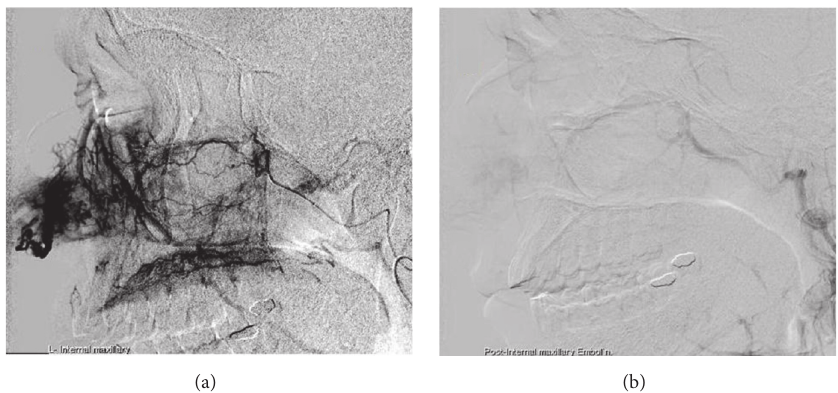
Figure 3: (a) Angiography showing hypervascular nasal mass supplied by the distal branches of the left internal maxillary artery and distal branches of the left facial artery. (b) The mass after embolization of the internal maxillary artery.